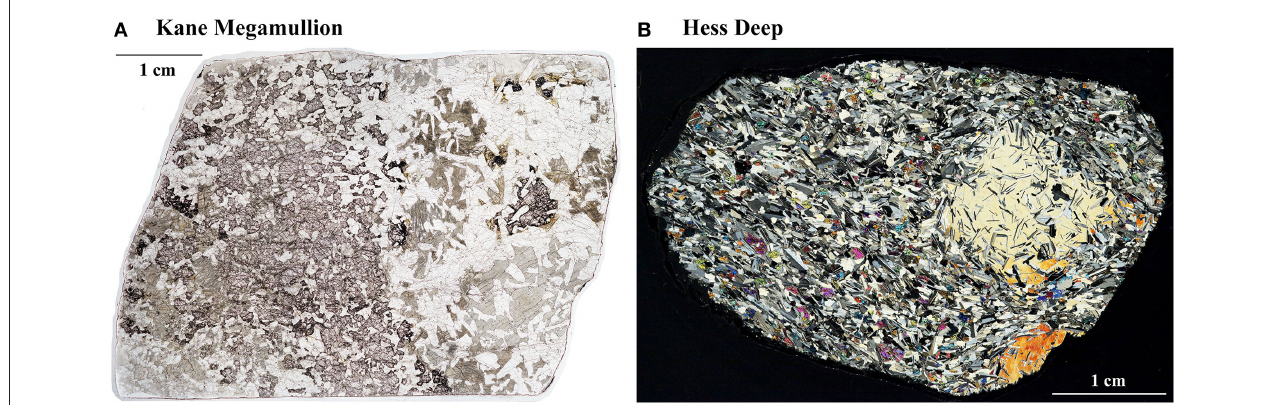
Figure A.1 and Presentation 1 . (B) Hess Deep (2 ◦ 15 ′ N, 101 ◦ 33 ′ W, East Pacific Rise) U1415I_4R_2_9-13 lower oceanic crust sample (see Gillis et al., 2014b) with clinopyroxene oikocrysts in a foliated troctolitic groundmass. See also Figure A.2